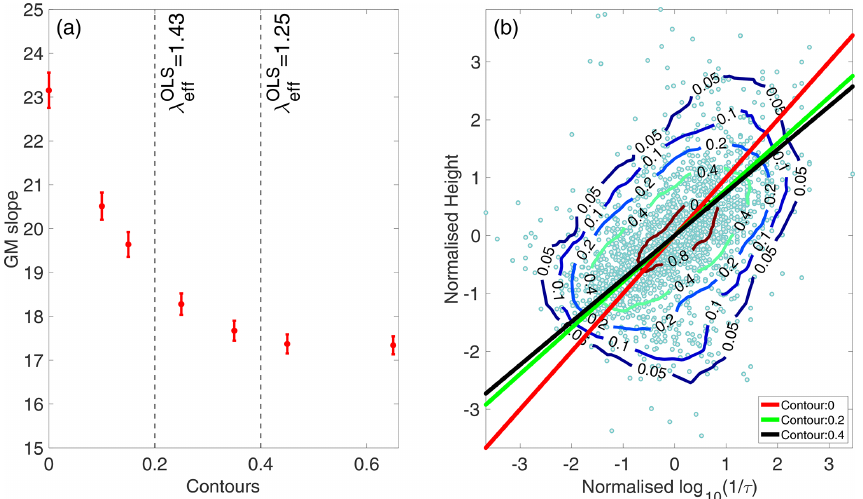
Figure 4. GM solution at different contour levels in (a) original coordinate and in (b) normalised coordinate for the date 14 November 2015. The vertical dashed lines in (a) correspond to the average value of λ obtained from SCT calibration at contour level 0.2 and 0.4 respectively for winter 2015–2016. The error bar in (a) corresponds to 2 σ error .